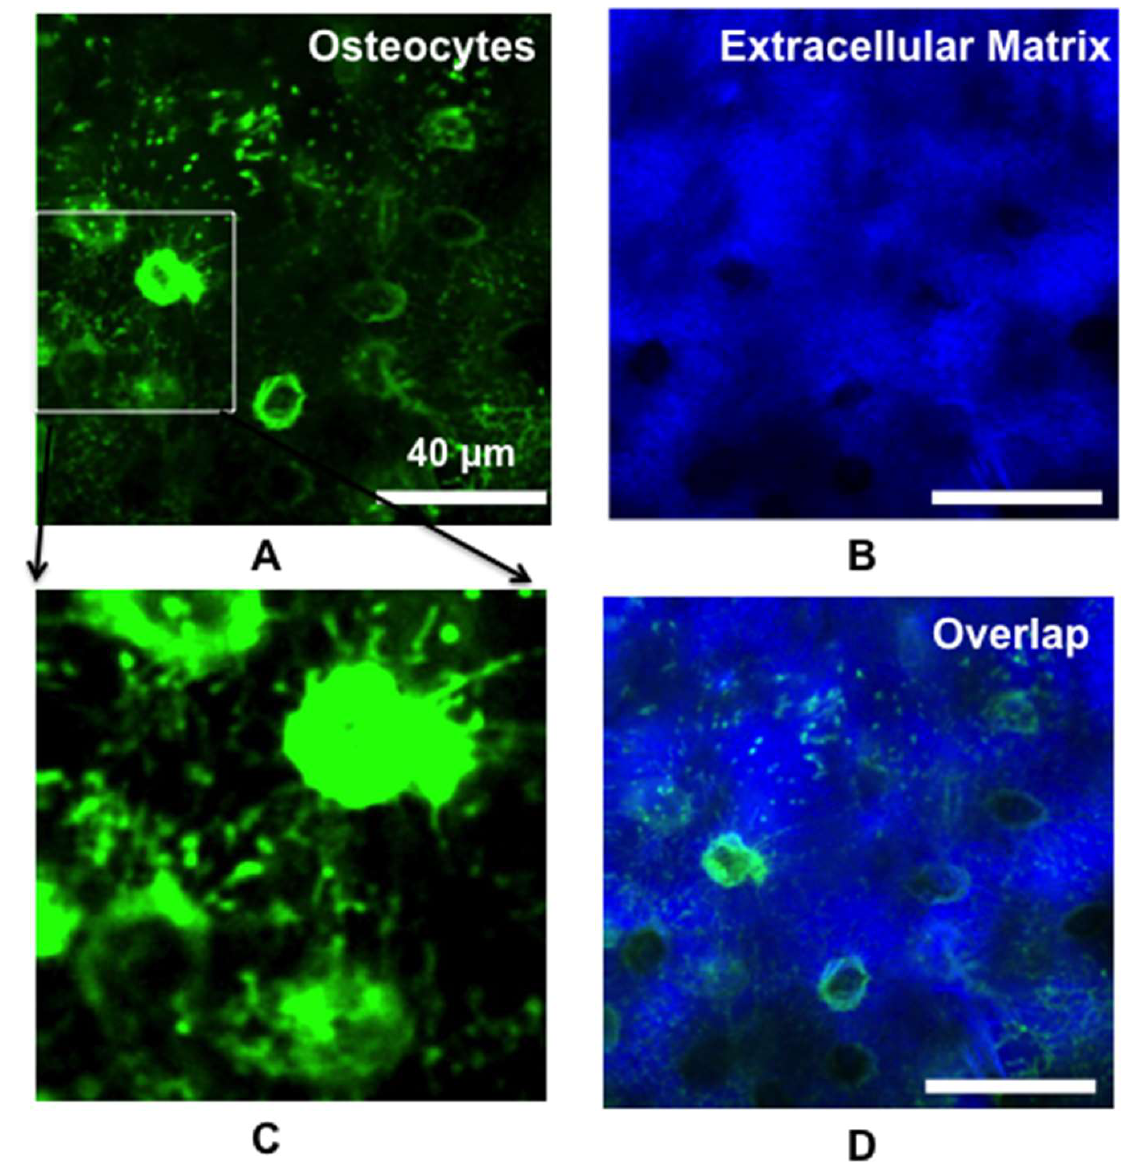
Figure 2. Intravital two-photon imaging of osteocytes: ( A ) Osteocytes were connected to one another through a network of cytoplasmic projections; ( B ) Extracellular matrix; ( C ) Magnification of the inset in Figure 2A; ( D ) Overlap of Figure 2A and 2B.